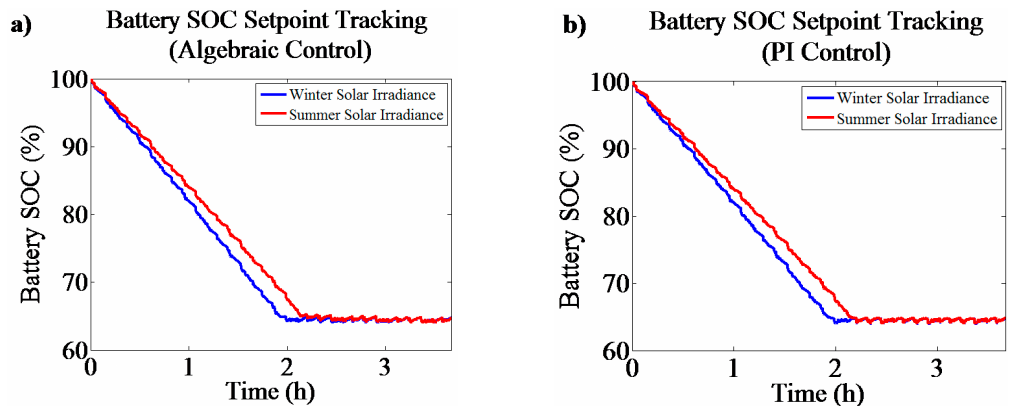
Figure 7. Battery state of charge of the PV/fuel cell/battery bus operations under standard conditions: Simulation results using ( a ) algebraic control and ( b ) PI control. Each control strategy is effective in maintaining the battery SOC close to the desired 65% for both summer and winter solar irradiance